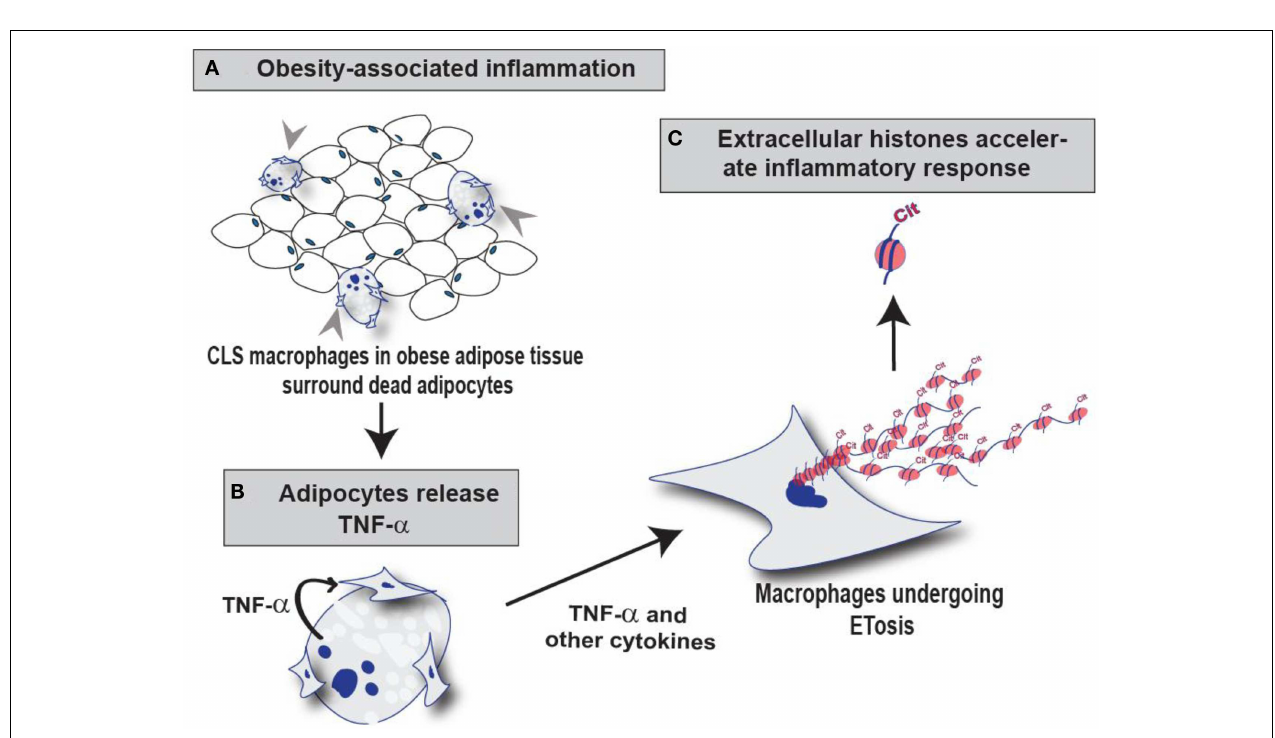
PAD2-mediated histone citrullination, chromatin decondensation, and extracellular chromatin scaffold formation. (C) We hypothesize that the citrullinated histones released during MET formation may regulate the inflammatory microenvironment of mammary adipose tissue by influencing the macrophage infiltration and/or macrophage